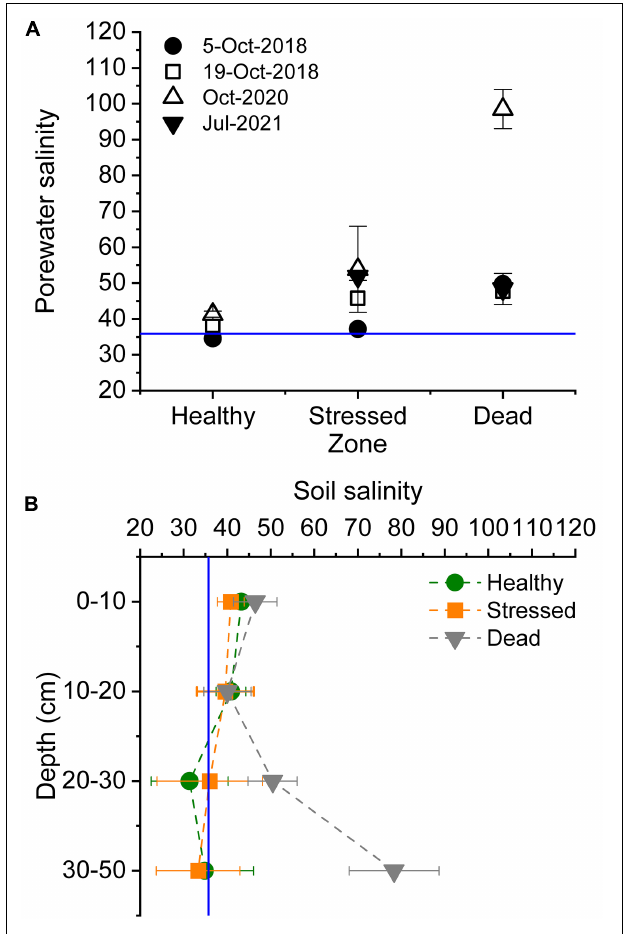
FIGURE 3 | Salinities throughout the mangrove zones at St Kilda, South Australia, in (A) porewater in the shallow root zone of mangrove measured on several occasions before and after the dieback commenced (October 2020), and (B) in soil (1:5 soil water extract) over several depth measured in mid-2021. The blue lines indicate mean seawater